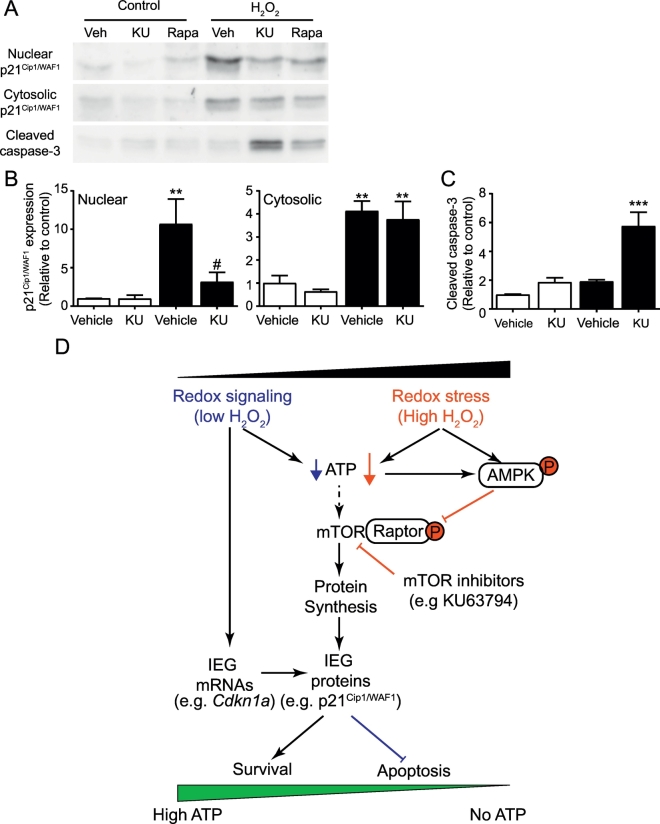
Inhibition of mTOR reduces the increase in expression of nuclear p21Cip1/WAF1 in cardiomyocytes induced by H2O2 and promotes apoptosis. (A) Cardiomyocytes were unstimulated (Control) or exposed to 0.2 mM H2O2 (2 h) in the presence of 1 μM KU63794, 10 μM Rapamycin or vehicle only. (B and C) Nuclear or cytosolic samples were immunoblotted with antibodies to p21Cip1/WAF1, [(A) and (B)] or cleaved caspase 3 [(A) and (C)]. Data are means ± SEM (n = 3 independent myocyte preparations); *p < .05, **p < .01, ***p < .001 relative to vehicle control; #p < .05 relative to H2O2 (one-way ANOVA with Tukey post-test). (D) Schematic for regulation of signalling and gene expression under conditions of redox stress vs signalling. In conditions of low H2O2, immediate early genes (IEGs) are upregulated and mTOR is activated to promote protein synthesis, leading to production of antioxidant enzymes and cytoprotective proteins such as p21Cip1/WAF1 to alleviate the stress of increased oxidative burden. Under conditions of high H2O2, ATP levels fall dramatically causing activation of AMPK with phosphorylation of Raptor, inhibition of mTORC1 and decreased protein synthesis. Cells are unable to synthesise cytoprotective proteins such as p21Cip1/WAF1 and undergo apoptosis.